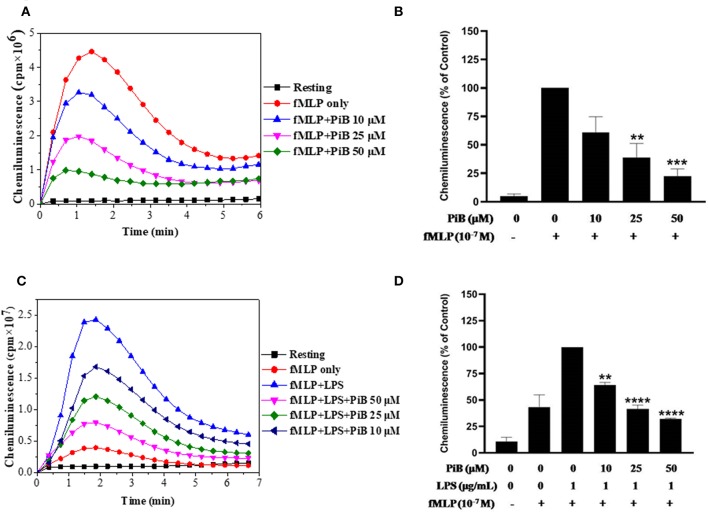
Effect of PiB, a Pin1 inhibitor on fMLP-induced and LPS-primed ROS production by human neutrophils. (A) Human neutrophils (1 × 106/ml) were incubated in the absence or presence of increasing concentrations of PiB for 20 min at 37°C, then stimulated with fMLP (10−7 M). ROS production was measured with a luminol-amplified chemiluminescence technique. (B) Total chemiluminescence in each experimental condition is expressed as mean plus or minus SEM of 3 experiments. **p < 0.05 and ***p < 0.01 as compared with fMLP alone (control 100%). (C) Human neutrophils (1 × 106/ml) were incubated in the absence or presence of increasing concentrations of PiB for 20 min at 37°C, then LPS (1 μg/mL) was added for another 20 min before stimulation with fMLP (10−7 M). ROS production was measured with a luminol-amplified chemiluminescence technique. (D) Total chemiluminescence in each experimental condition is expressed as mean plus or minus SEM of 3 experiments. **p < 0.05, ****p < 0.001 as compared with control (100%).